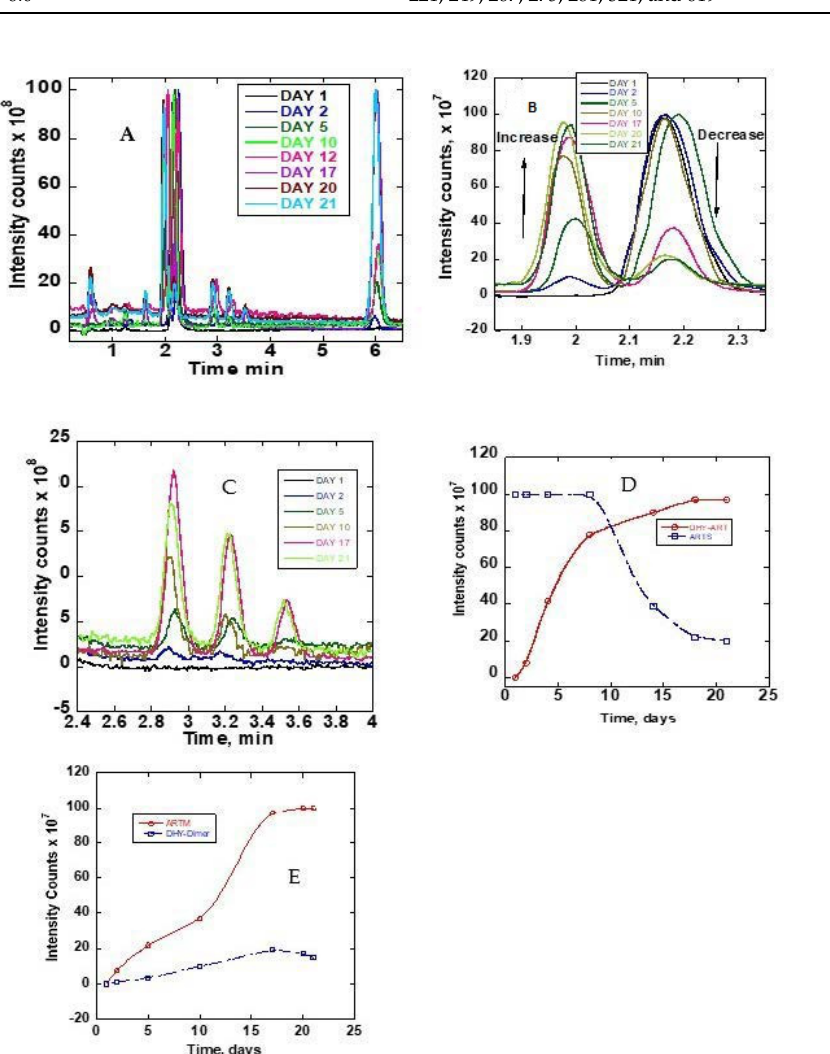
Figure 3. ( A ) TIC chromatograms of ARTS reaction in methanol/water (90:10) monitored as a function of time (days). ( B ) Zoomed-in TIC chromatograms at 1.8 to 2.4 min. ( C ) Zoomed-in TIC chromatograms at 2.4 to 4.0 min. ( D ) Peak intensities as a function of time of DHA and ARTS. ( E ) Peak intensities as a function of time. The ARTS peak at 2.1 min continuously decreased, while the DHA peak at 1.9 min and the ARTM peak at 6.0 min continuously grew. The parent peak of ARTS decreased to about 80% in 21 days. As compared to ARTS, the percentage increases of the DHA, ARTM and DHA dimers were 97%, 100% and 15%, respectively. The DHA increase was almost by the same margin as the reduction of ARTS. Although the initial concentration of ARTS was high, as shown on the plateau region of the detector, it was clear that it led to the formation of other product chromatographic peaks. In this solvent system, DHA and ARTM plateaued after 15 and 17 days, respectively (Figure 3D, E). The decline of the chro- matographic peak of ARTS was much slower after 20 days. The mass spectra of the reaction products corresponding to Figure 3A, B are given in Figure S2. The major fragment ions include [M+Na] + , [M+ K] + and [2M+Na] + , correspond-